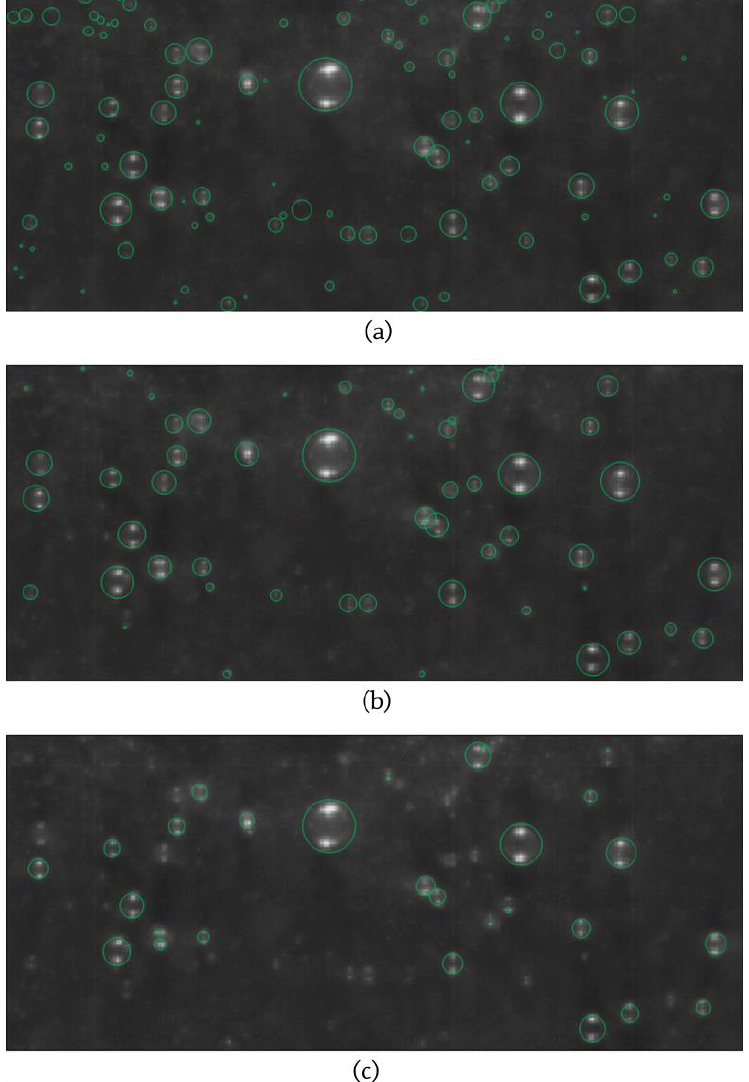
Figure 5. Dynamic threshold sensitivity for the front projection T b = 85 °C, p = 150 kPa, G = 484 kg/s·m 2 , q w = 450 kW/m 2 : ( a ) threshold value: 8; ( b ) threshold value: 16; ( c ) threshold value: 48. Absolute values on a scale from 0 (black) to 255 (white).